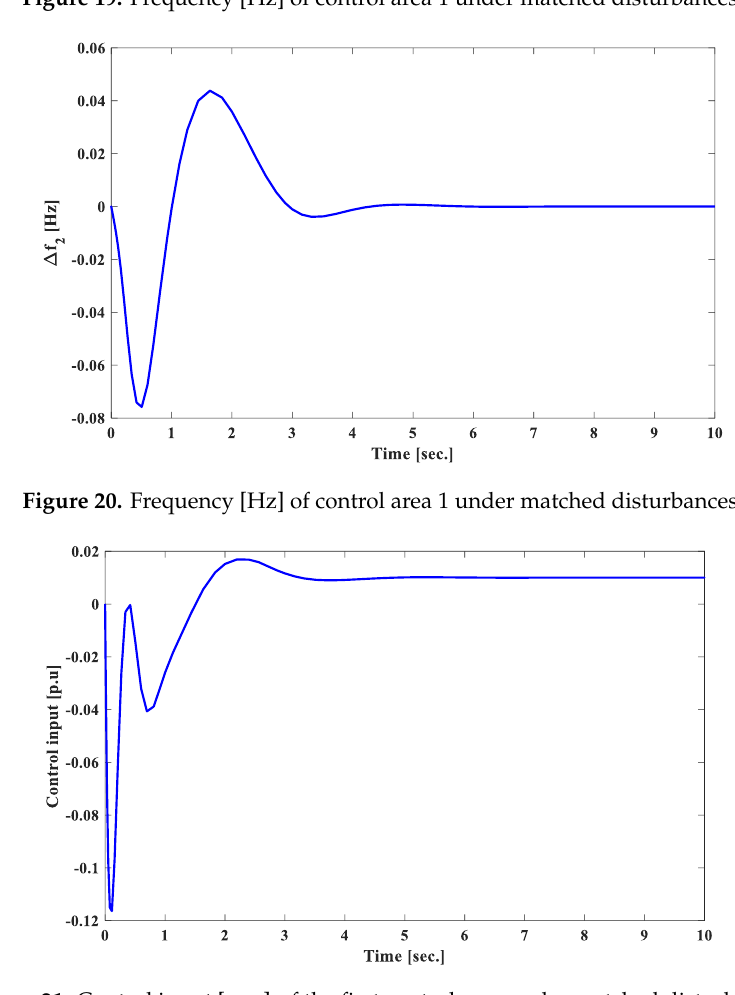
Figure 22. Control input [p.u.] of the second control area under matched disturbances.